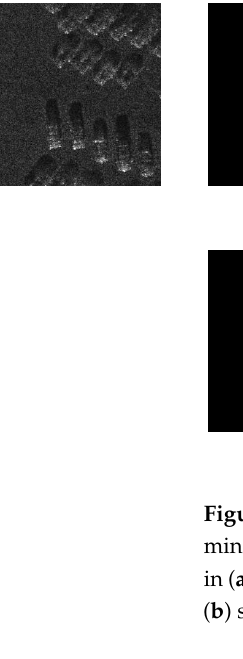
16 of 23 Figure 6. The ablation study results of the F1-scores for our method with different percentages of labeled training samples on the miniSAR dataset.  Reconstruction performance The proposed semi-supervised method is taught with the training images, in which